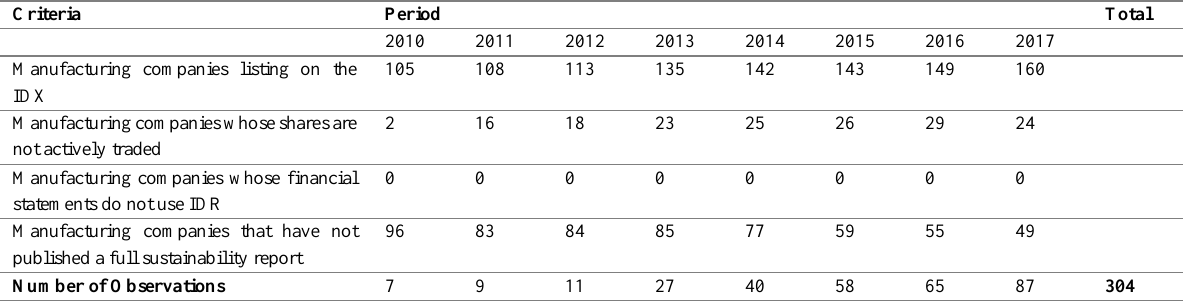
Table 5 : Results of determination of research samples